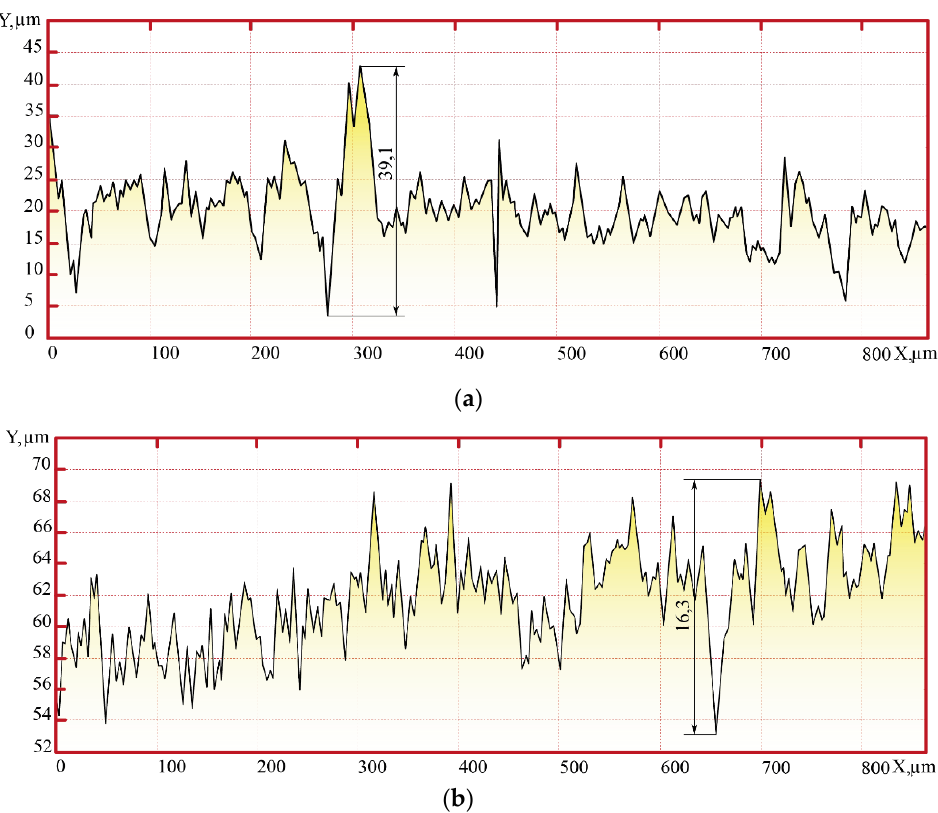
Figure 8. Microtexture of the surface being processed. At the initial moment of operation (low concentration of contaminants) ( a ), and just before the wire breakage (critical level of contamination) ( b ).